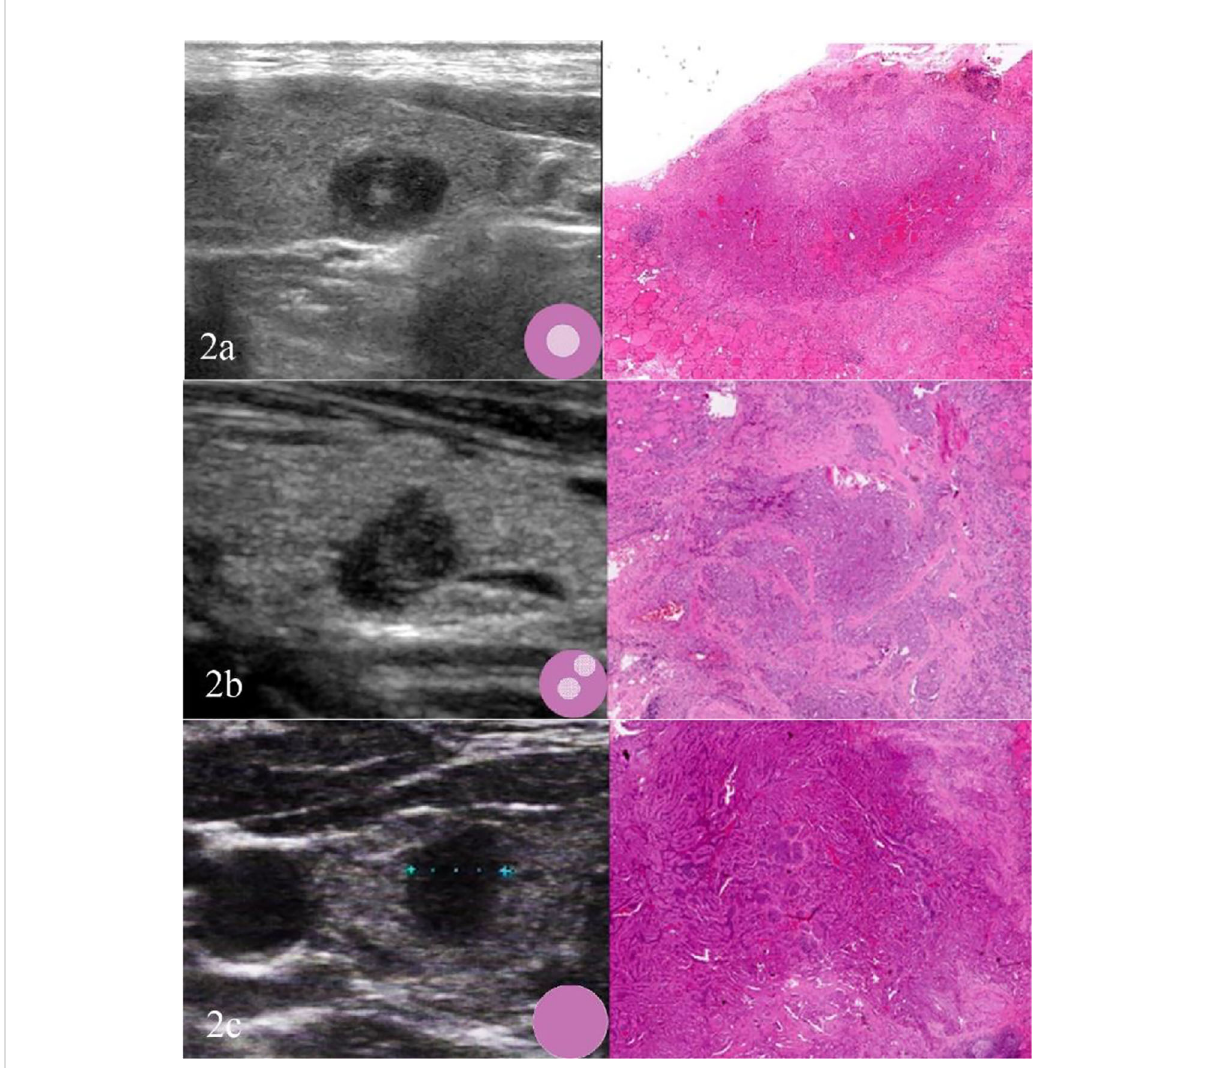
FIGURE 2 Three cases of TCV-PTMC. (A) US of the left thyroid gland in a 57-year-old woman shows a hypoechoic nodule with a localized central isoechoic region and a hypoechoic halo. This nodule has a regular margin and a diameter of 7 mm (left). Hematoxylin and eosin staining (×40) shows an irregular pink fi brous stromal center that is surrounded by epithelium (right). (B) US of the left thyroid gland in a 63-year-old woman shows a hypoechoic nodule with a localized noncentral isoechoic region. This nodule has an irregular margin and a diameter of 8 mm (left). Hematoxylin and eosin staining (×40) shows an irregular pink region indicating a randomly distributed stroma (right). (C) US of the right thyroid gland in a 44-year-old woman shows a hypoechoic nodule without a localized isoechoic region. This nodule has a regular margin and a diameter of 7 mm (left). Hematoxylin and eosin staining (×40): shows a hypercellular tumor with scant stromal components